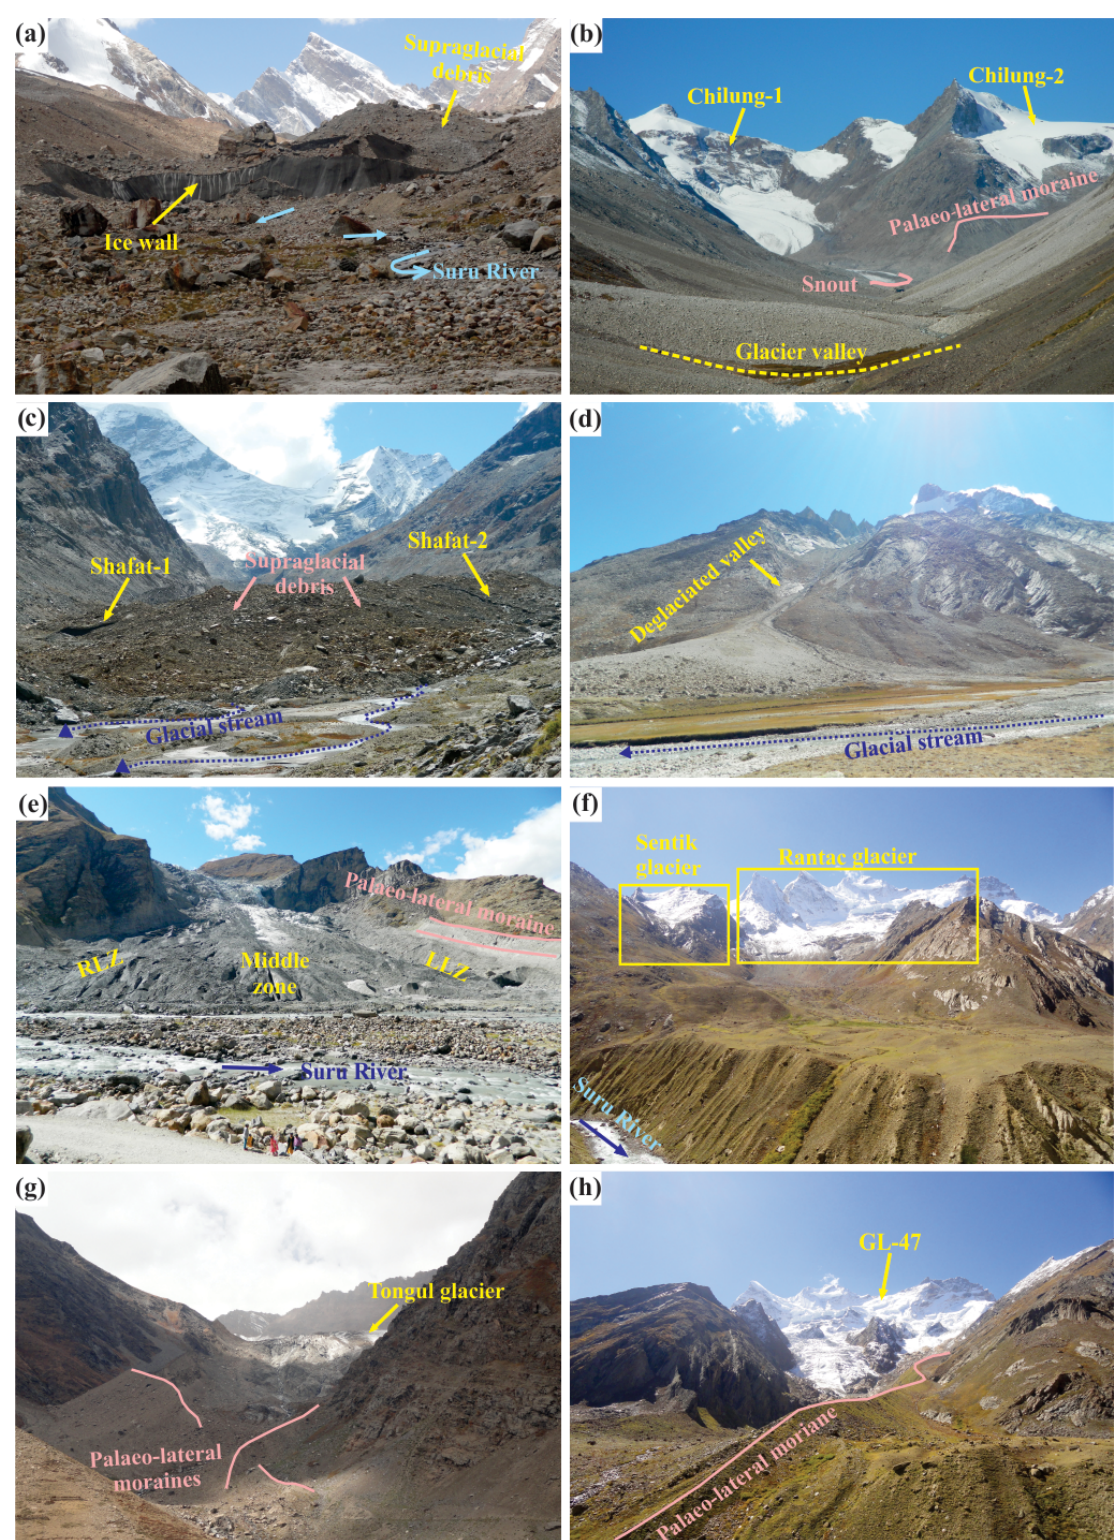
Figure 2. Field photographs of some of the investigated glaciers in the study area captured during the field visits in September 2016 and 2017. Snouts of (a) Pensilungpa, (b) Chilung, (c) Shafat, (e) Kangriz, (f) Sentik and Rantac, (g) Tongul and (h) glacier no. 47. (d) Deglaciated valley near the Shafat